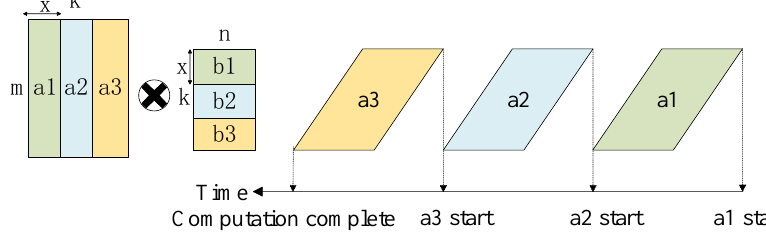
Figure 7. Example of data dependency within the